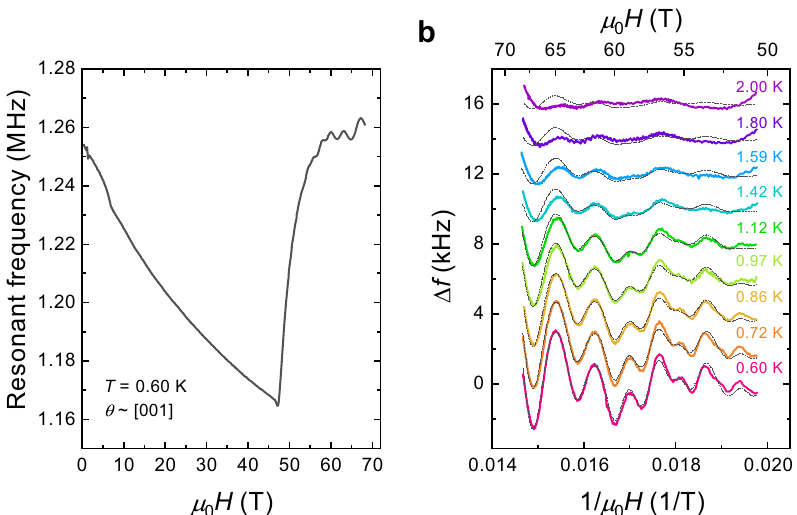
Fig. 1 Quantum oscillations in the fi eld-induced metallic phase of YbB 12 . Electrical resistivity of a single crystal of YbB 12 measured with the contactless proximity detector oscillator (PDO) technique. a PDO resonant frequency as a function of applied magnetic fi eld up to 68 T at a temperature of 0.60 K with the fi eld aligned close to the [001] crystallographic direction. The sharp change in resonant frequency at μ 0 H ≈ 47 T indicates the onset of the insulator-metal transition 8,9 . Prominent oscillations can be seen against the unsubtracted background above μ 0 H ≈ 50 T. b Solid lines show quantum oscillations measured with PDO up to 68 T with a smooth monotonic background subtracted at different temperatures, where Δ f is the change in resonant frequency after background subtraction. Dashed lines show Lifshitz-Kosevich simulations of quantum oscillations using multiple frequency components as listed in Table 1.